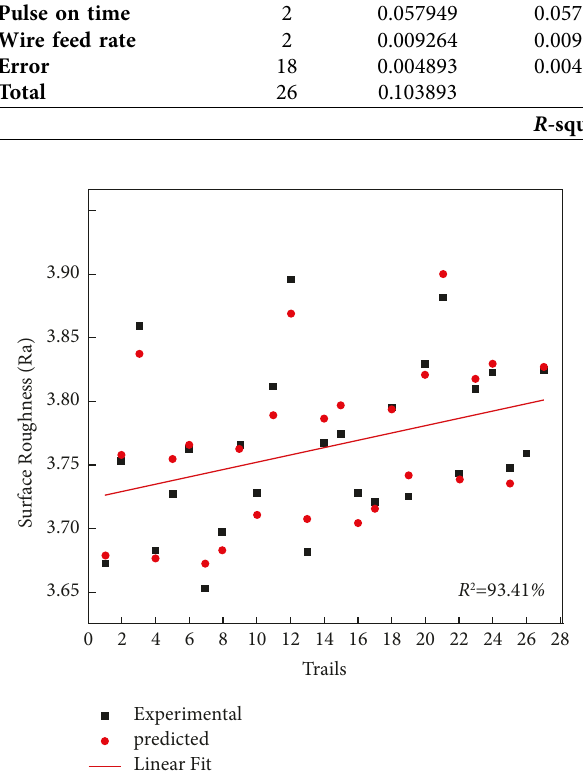
Figure 5: Variation between experimental and predicated values of surface roughness.